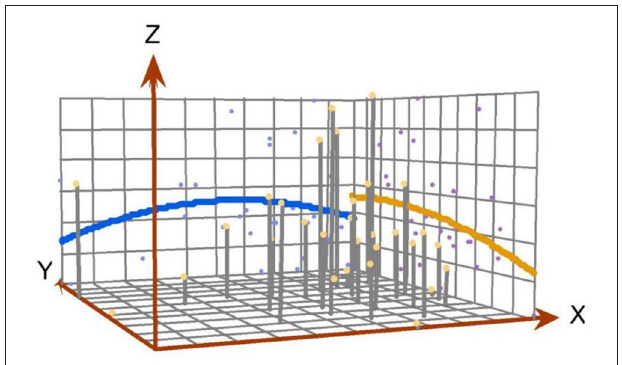
which indicates that the Chinese government is committed to improving the atmosphere environment.